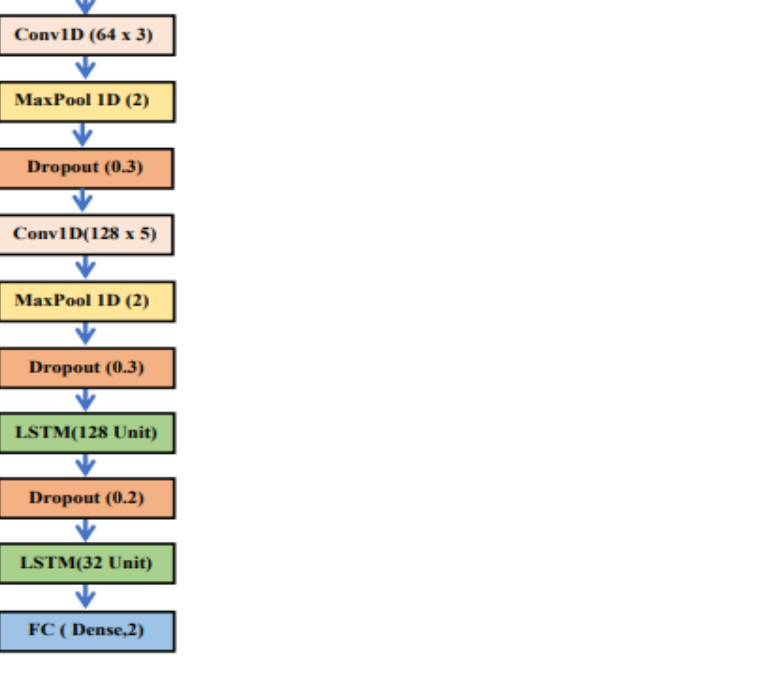
Figure 7. The suggested 1D CNN-LSTM model ’ s structure (frequency domain).